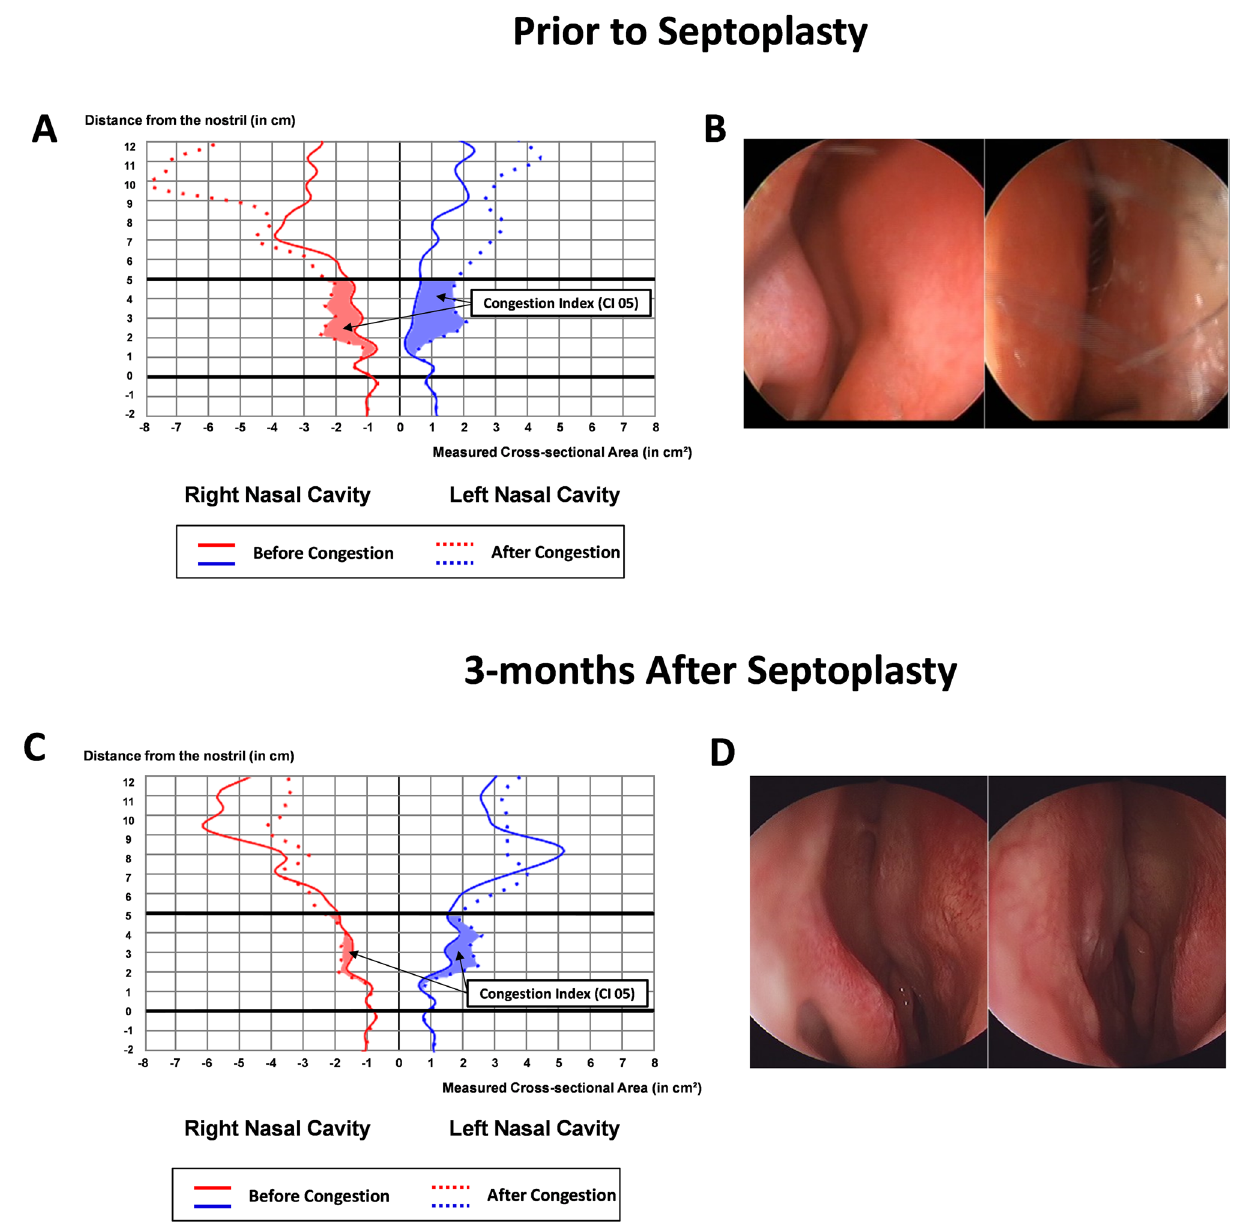
Figure 1. Evaluation of the nasal airway after septoplasty. An endoscopic examination with the acoustic rhinometry evaluation in a 27-year old male patient with the deviated nasal septum. Visualization of the narrowed nasal airway on the left side is well observed with the endoscopic exam ( B ) and acoustic rhinometry ( A ). The nasal septum is well straightened with the widening of the left nasal cavity 3 months after septoplasty with bilateral lateralization of the inferior turbinate ( D ). Equalization of the bilateral nasal airway was achieved as shown on the acoustic rhinometry ( C ). Remarkably, the swelling of the nasal mucosa has decreased ( B , D ) as shown in the decrease in the congestion index on the acoustic rhinometry ( A , C